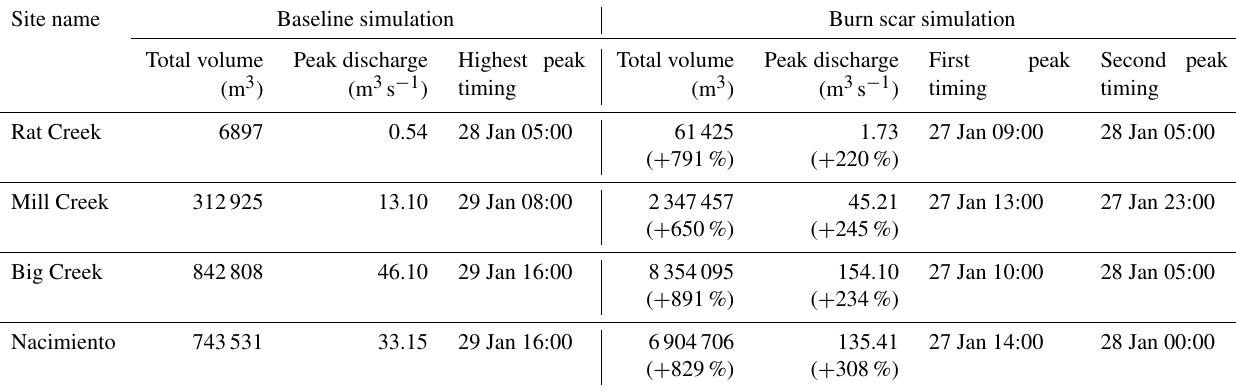
Table 2. The total runoff volume, peak discharge, and peak timing in the baseline and burn scar simulations from 27 January 00:00 to 31 January 23:00 at deposition sites of Rat Creek, Mill Creek, Big Creek, and Nacimiento debris flows (black triangles in Fig. 7a–d). The peak timing shown in the baseline simulation is for the highest peak. The percent changes in the total volume and peak discharge in the burn scar simulation relative to the baseline simulation are shown in parentheses.